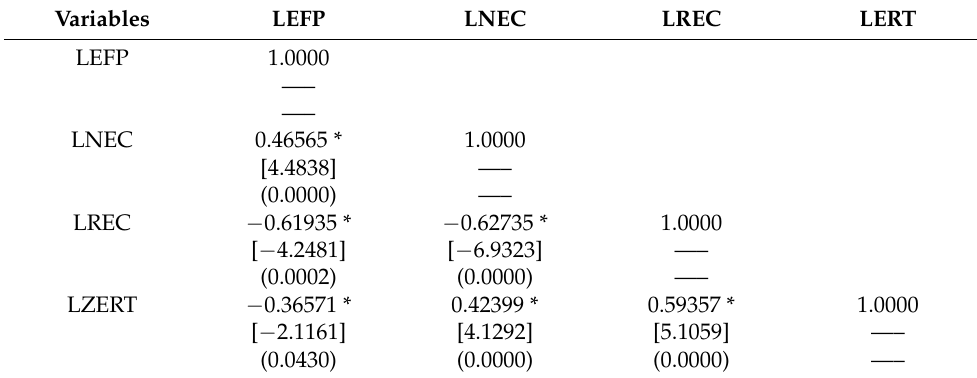
Table 4. Pearson correlation matrix.